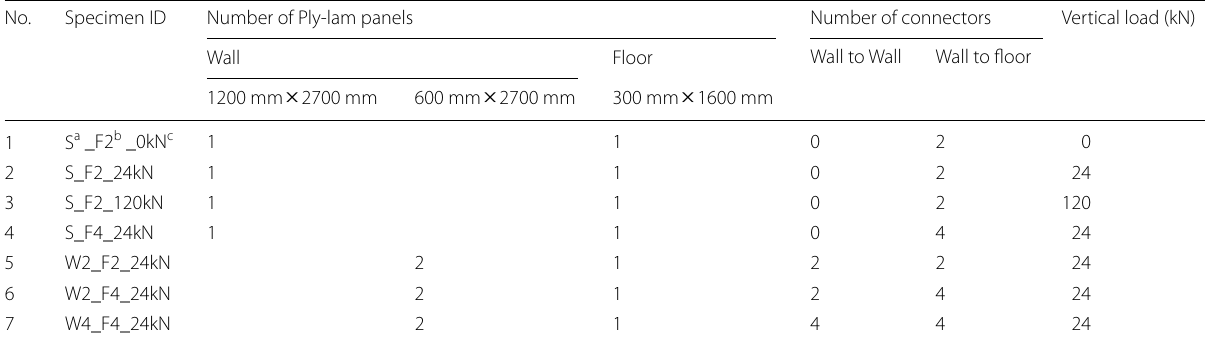
Table 1 Specimens for Ply‑lam shear wall